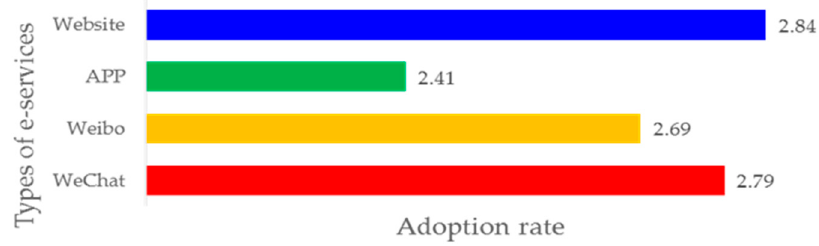
Figure 2. Adoption of four types of local e-government services.